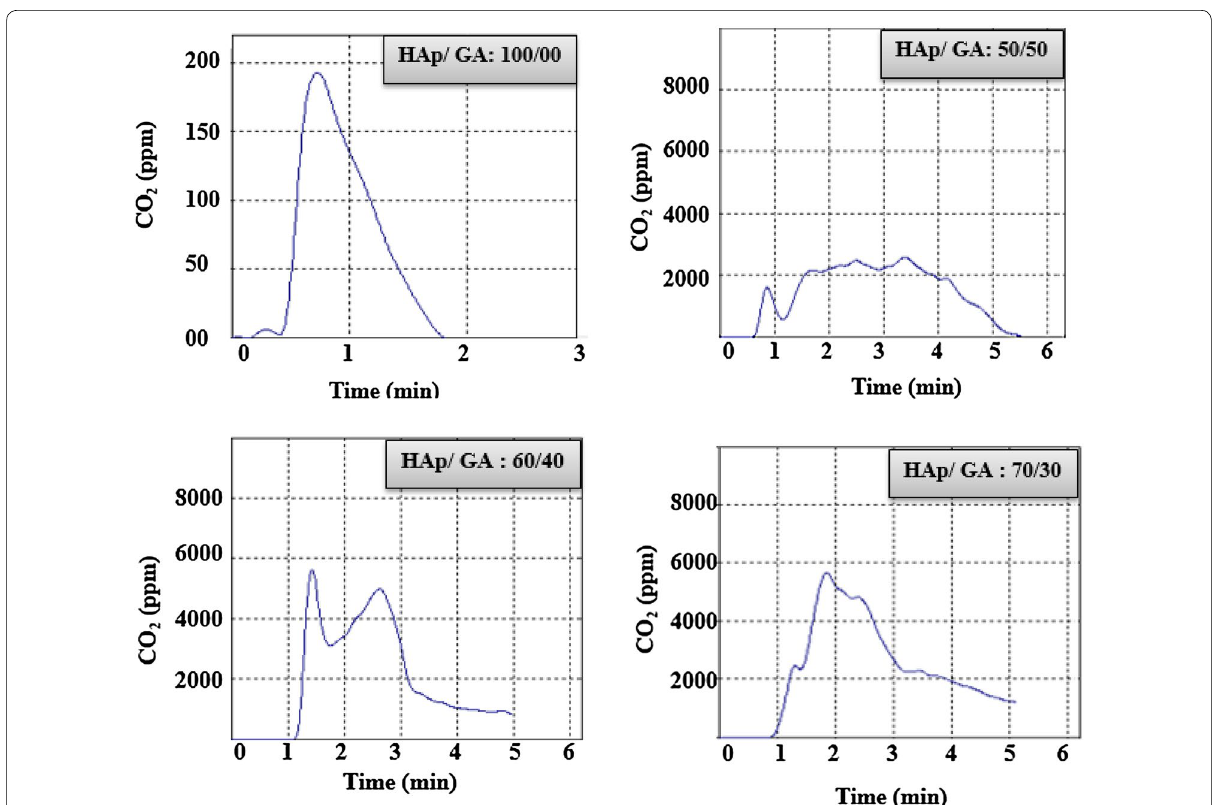
Fig. 7 Plot of TOC versus time for HAp and HAp/GA composite scaffold